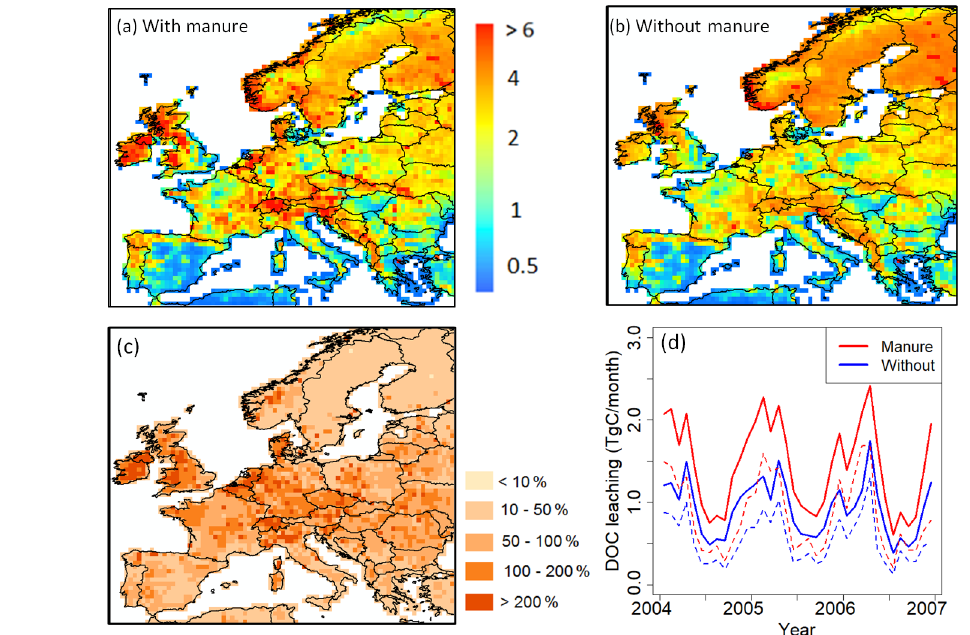
Figure 11. Comparison of modeled yearly mean terrestrial DOC leaching flux (period 1979–2006) into the European river network (in gCm − 2 yr − 1 ), with (a) and without (b) the representation of manure application. (c) Increase of DOC leaching in percentage com- pared to DOC leaching without manure implementation. (d) Comparison of total DOC leaching (solid line) and DOC leaching through runoff only (dashed line) throughout Europe with and without manure application (period